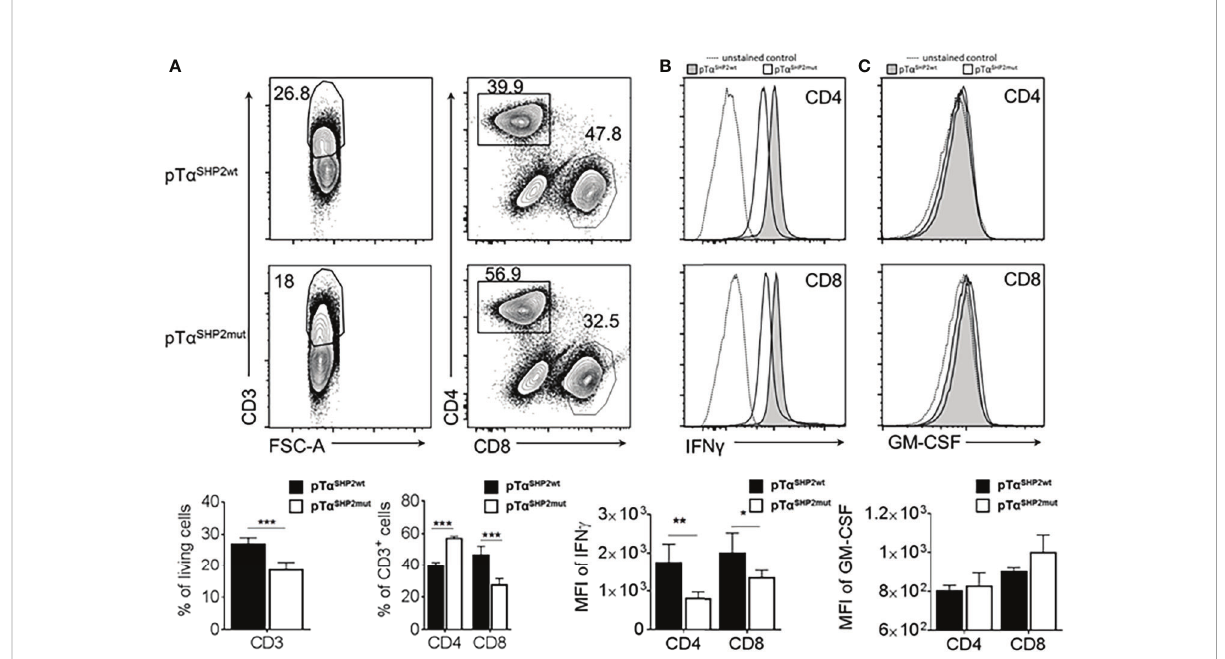
FIGURE 7 Altered T cell composition and reduced IFN g production in pT a SHP2mut mice. Splenocytes of PR8-OT-I IAV infected (8 days) SHP2 mutant and control mice were stimulated with 5µg/mL plate-bound a -CD3 and 1µg/mL soluble a -CD28 for 16 h. (A) FACS plots and graphs show frequencies of CD3 + T cells within living cells and shifted CD4 + :CD8 + T cell ratio within the CD3 + T cell population. (B) Reduced levels of IFN g in pT a SHP2mut cells were observed within the CD4 + and CD8 + T cell subset and (C) similar levels of GM-CSF expressed in both CD4 + and CD8 + T cell subsets. Histograms show the representative mean fl uorescence intensities of fl uorochrome-conjugated antibody against IFN g and GM- CSF for pT a SHP2wt mice (grey), pT a SHP2mut mice (white) and unstained control (MFI, dashed). Individual value plot represents the mean of fl uorescence intensity. Data is representative for 2 independent experiments with n=3 SHP2 mutant or 5 control mice. (*p<0.05, **p<0.01, ***p<0.001, Student ’ s t-test, mean +